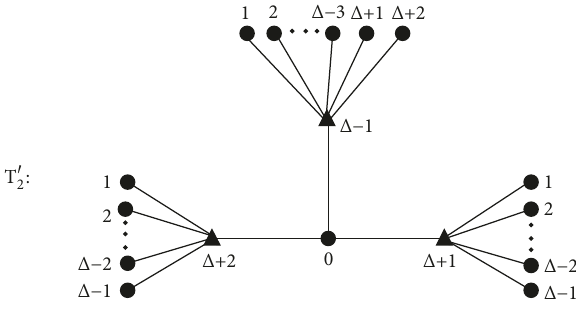
Figure 5: Irreducible 𝐿(2,1) -span coloring of 𝑇 󸀠 2 with one hole.